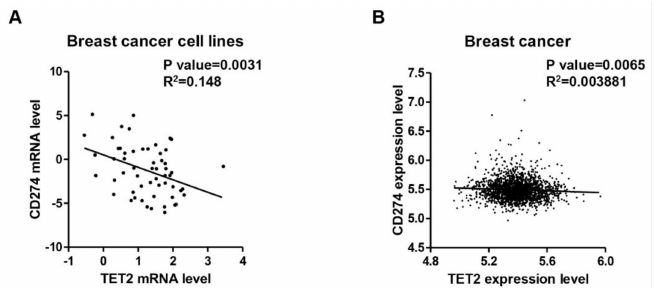
Figure 4. A negative correlation between TET2 and PD-L1 gene transcription in breast cancer. ( A ) CCLE data analysis showing a significant negative correlation between TET2 and PD-L1 expres- sion levels in breast cancer cell lines ( n = 57). ( B ) TCGA data analysis showing a mild but significant negative correlation between TET2 and PD-L1 expression levels in breast cancer tissues ( n =